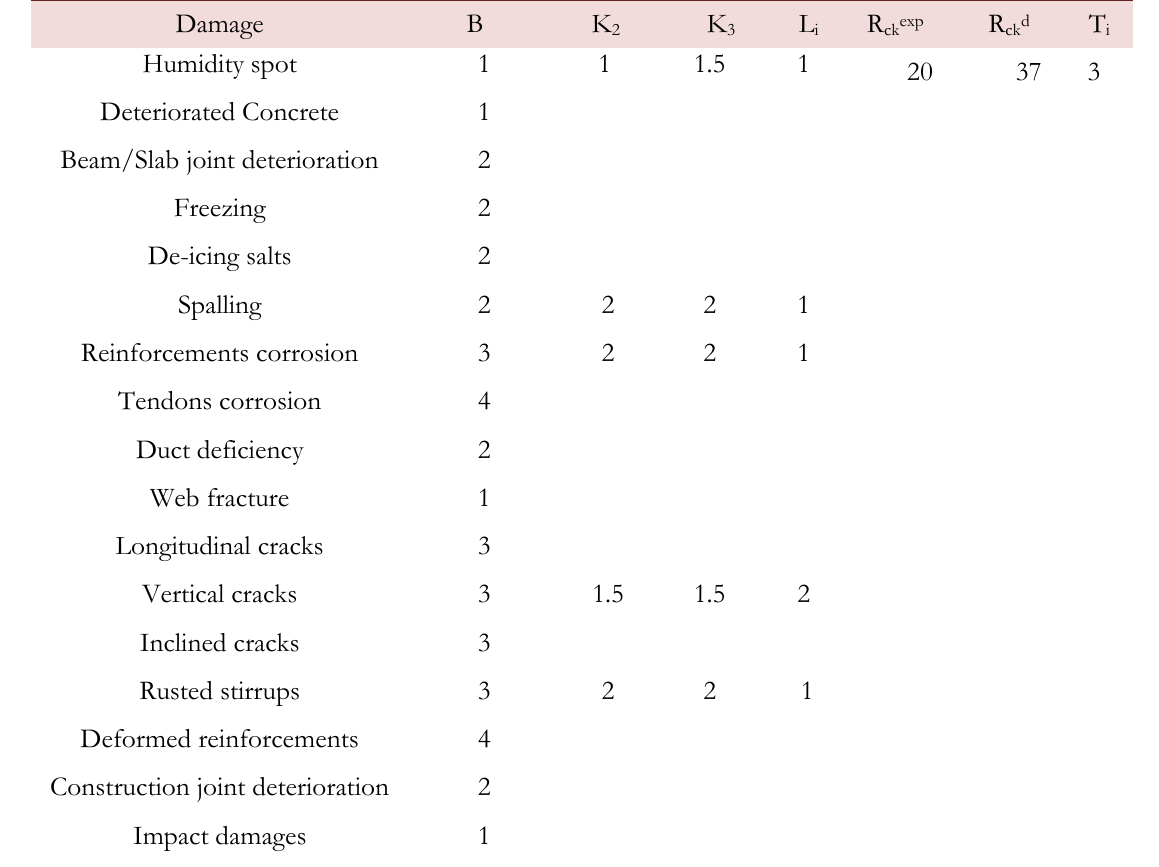
Table 7: Longitudinal beam damage identification form for Bridge